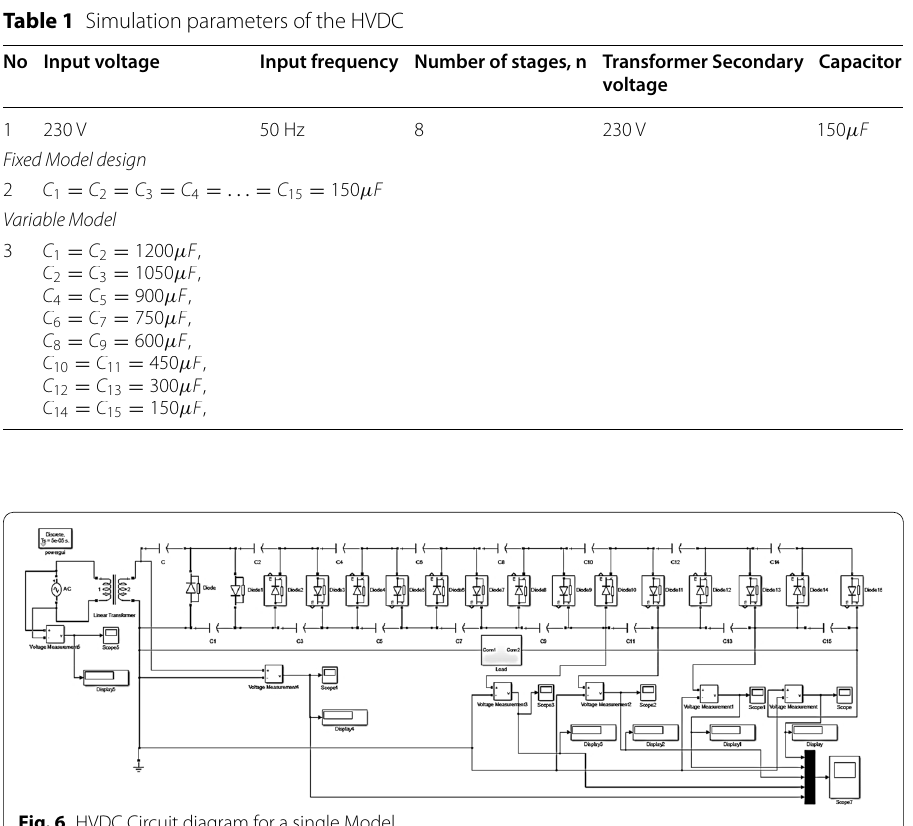
Fig. 6 HVDC Circuit diagram for a single Model